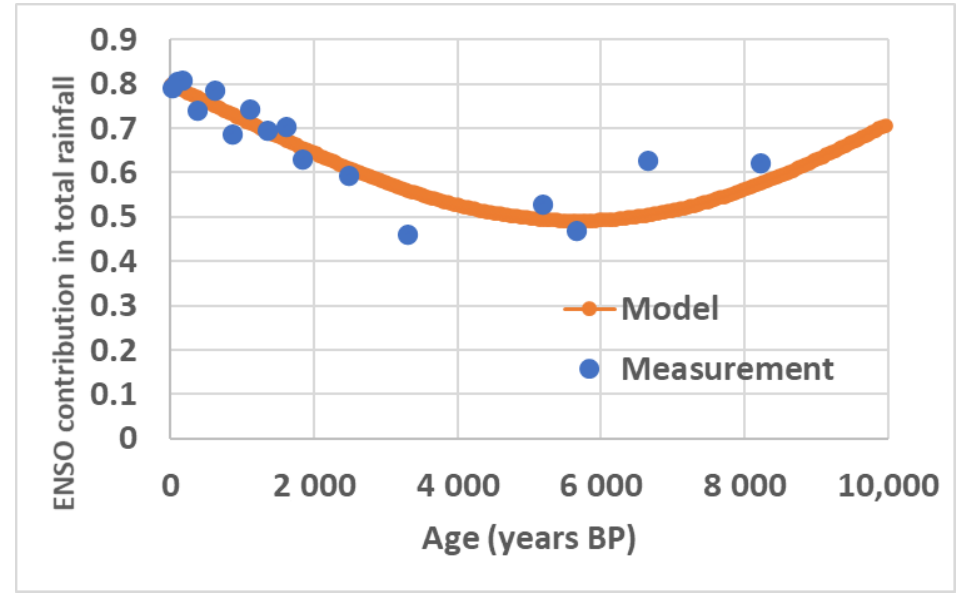
图 12 Figure 12. ENSO contribution to precipitation deduced from speleothems and the model—that is, δ 18 O concentration in the GRIP ice core filtered within the band 9216–73,728 Ka (union of subharmonic modes n 8 , n 9 , and n 10 ), and multiplied by a constant α to produce an adimenstional variable. This constant is a negative real number adjusted so that the quadratic sum of the deviations between the measurements and the model is